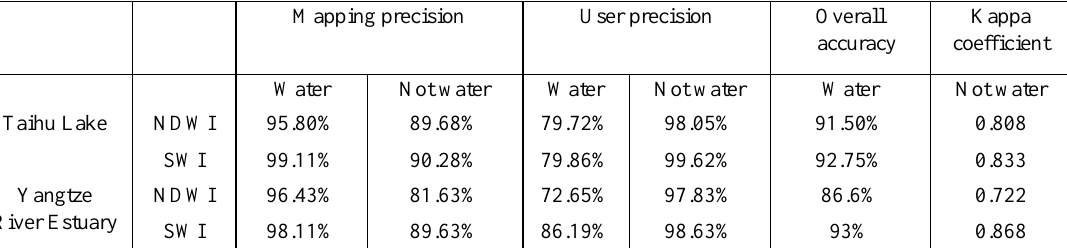
Table 3. Overall accuracy for each classification result